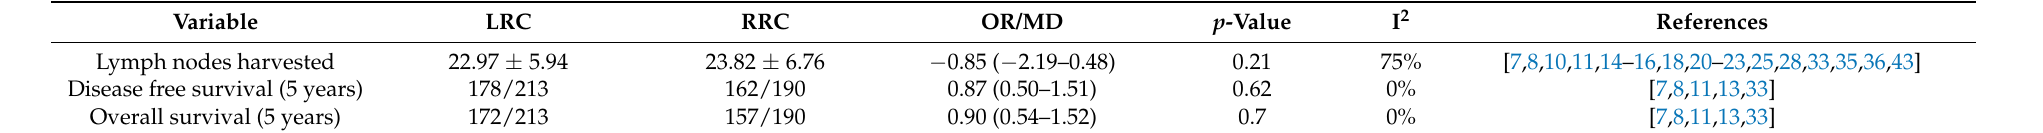
Table 4. Meta-analysis of oncological